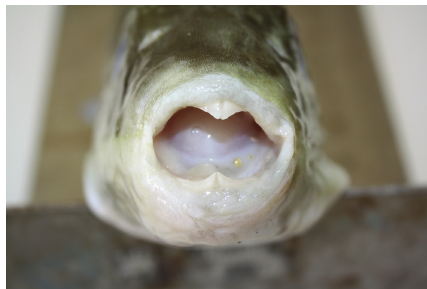
Figure 3: Particular of teeth of S.